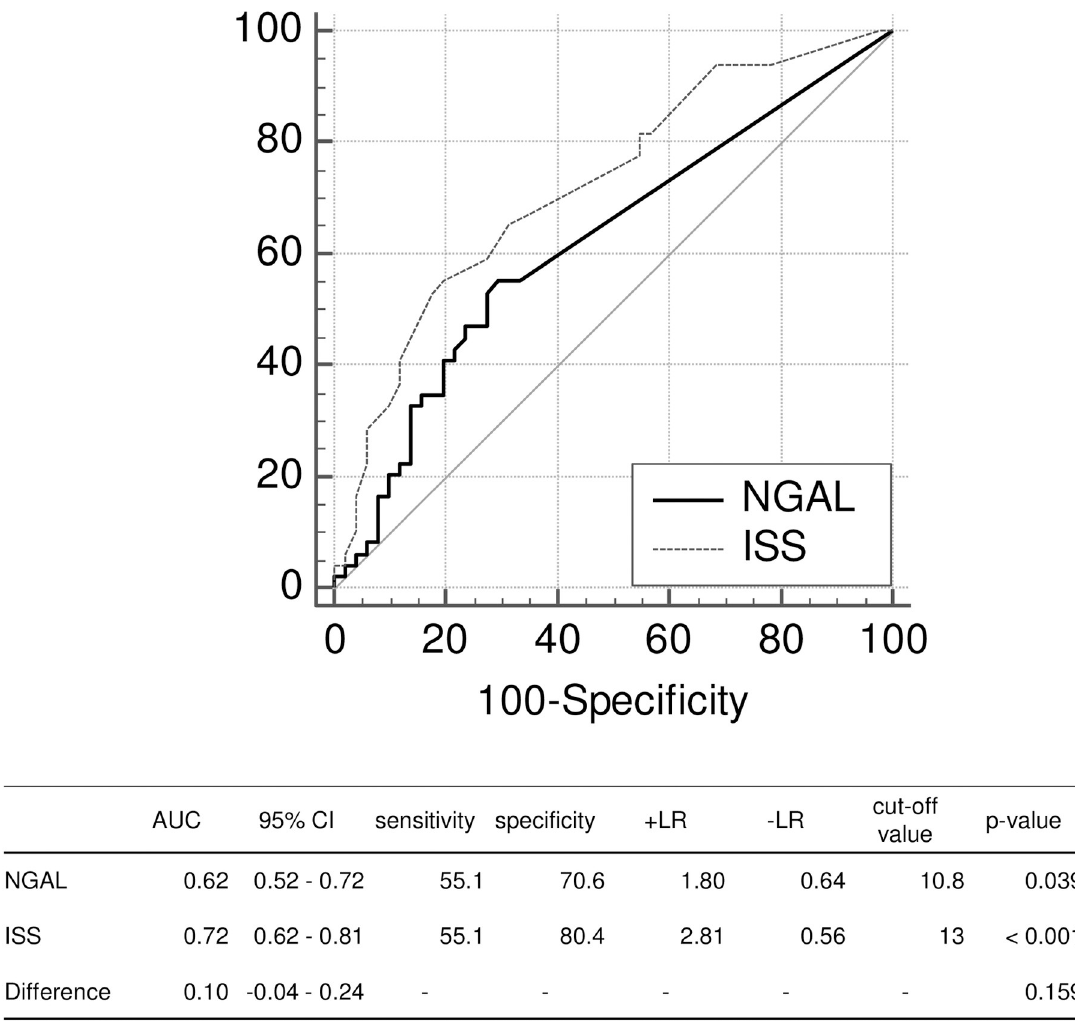
Fig 1. Comparison of the areas under the curve between NGAL levels and ISS on ICU stay. AUC: area under the curve; +LR: positive likelihood ratio; -LR: negative likelihood ratio; NGAL: neutrophil gelatinase-associated lipocalin; ISS: Injury Severity Score; ICU: Intensive Care